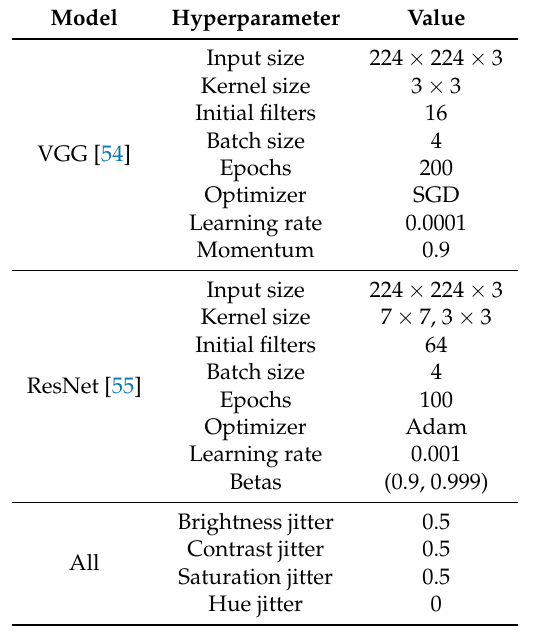
Table A1. Pretrained CNN implementation details. Hyperparameters for the pretrained 2D CNNs used for in-field classification. We refer the reader to references [54,55] for descriptions of the architectures of VGG and ResNet CNNs.